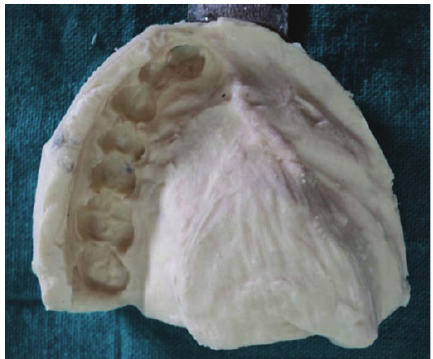
Figure 3: Primary impression.